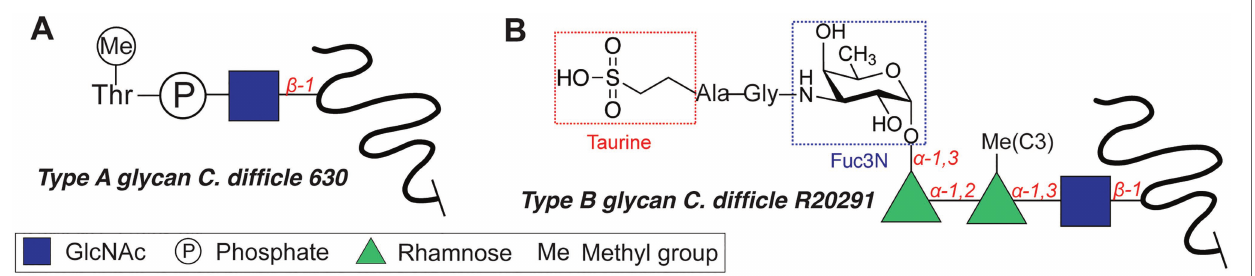
FIGURE 3 | Flagellar glycan structures of Clostridium difficile . (A) Type A glycan. (B) Type B